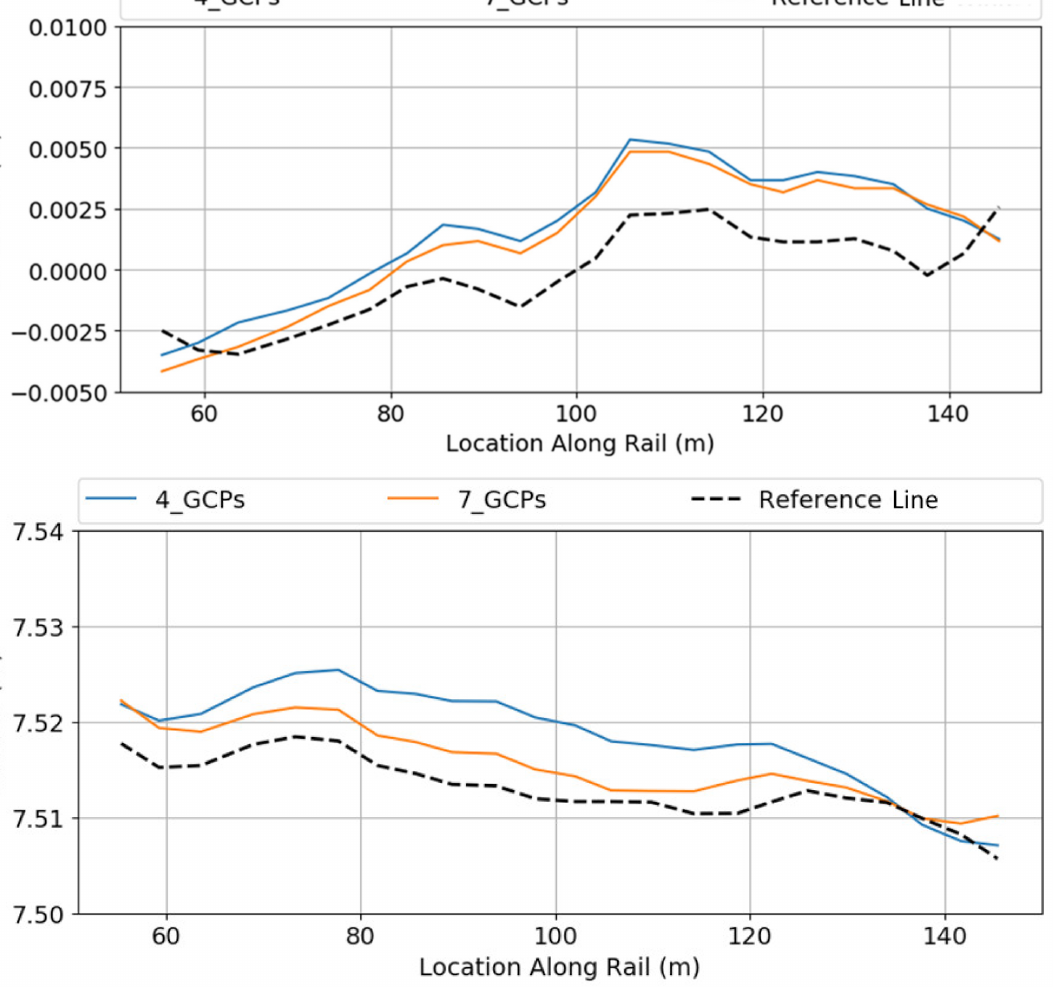
Figure 11. Top: comparison of XY deviation; bottom: elevation along the rail location with a reference data. Table 2. Error analysis of the extraction results with a reference for different comparison